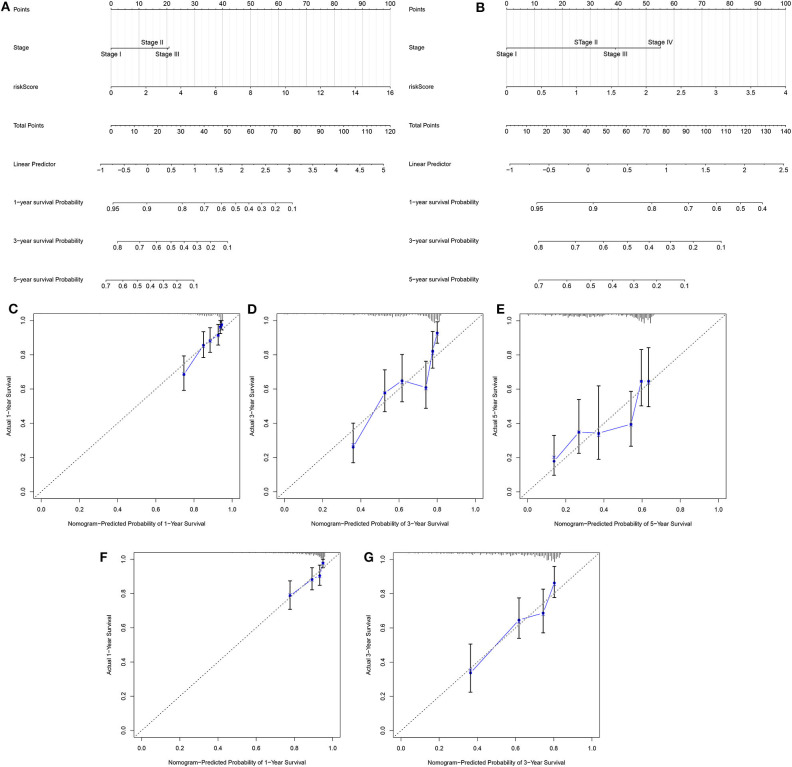
Development and verification of a nomogram for prediction of LUAD patients' 1-, 3-, and 5-year OS time. The nomogram including stage and risk score for prediction of 1-, 3-, and 5-year survival probability was conducted and verified in the (A) training set as well as (B) validation set. (C–E) Calibration plots showed the association between actual and the nomogram-predicted probability of 1-, 3-, and 5-year survival in the training set. (F,G) The association between actual and the nomogram-predicted probability of 1- and 3-year survival was confirmed in the validation set.